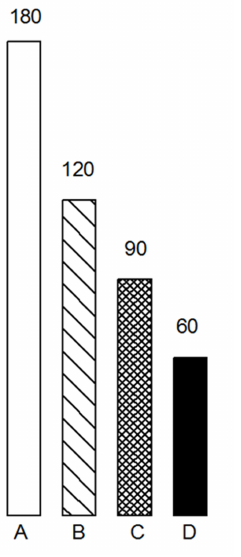
Figure 1. The presence of melanin in polymethyl methacrylate (PMM) inhibits the decay of free radical signal, induced by X-rays. A —450 mg of pure PMM, B —450 mg of PMM with 2 mg of melanin, C —450 mg of PMM with 4 mg of melanin, D —450 mg of PMM with 6 mg of melanin. Figure based on [47]. Copyright 1975